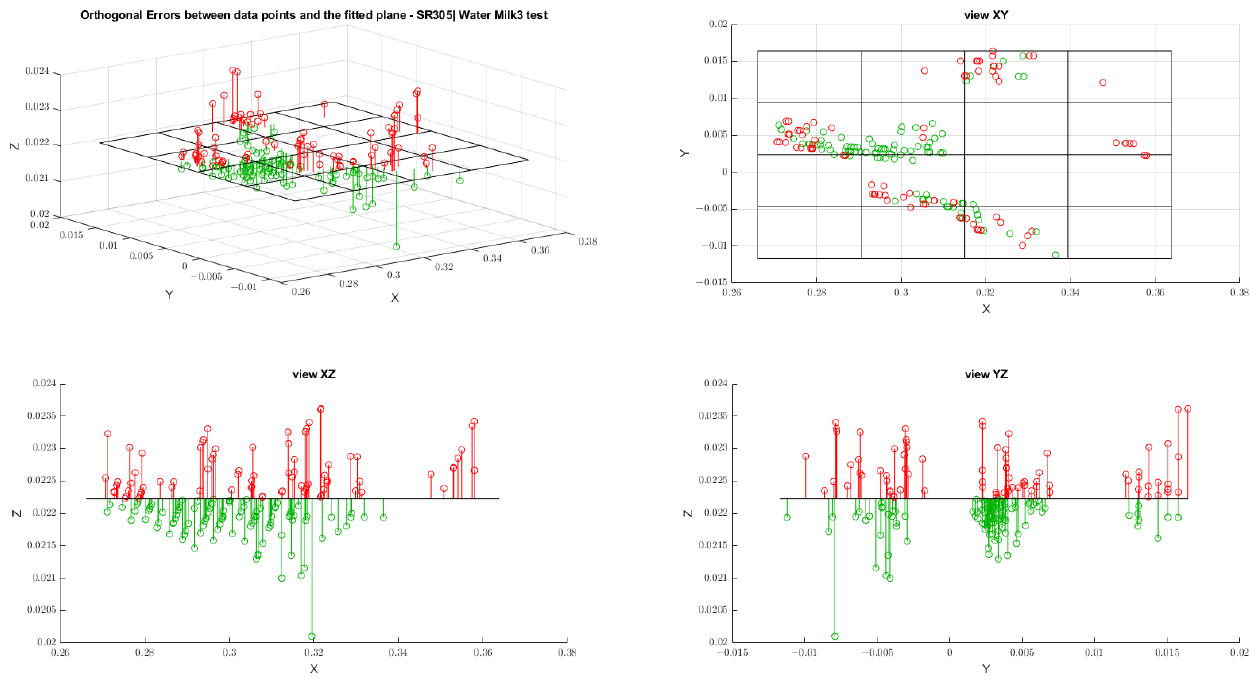
Figure A20. Results of orthogonal errors for the SR305 camera referring to the water milk3